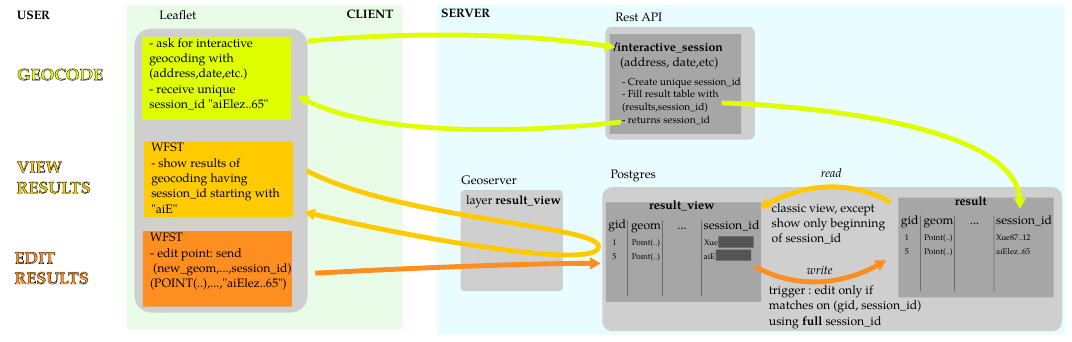
Figure 8. Collaborative display and edit is achieved through a mix of standards (REST , WFS-T) and